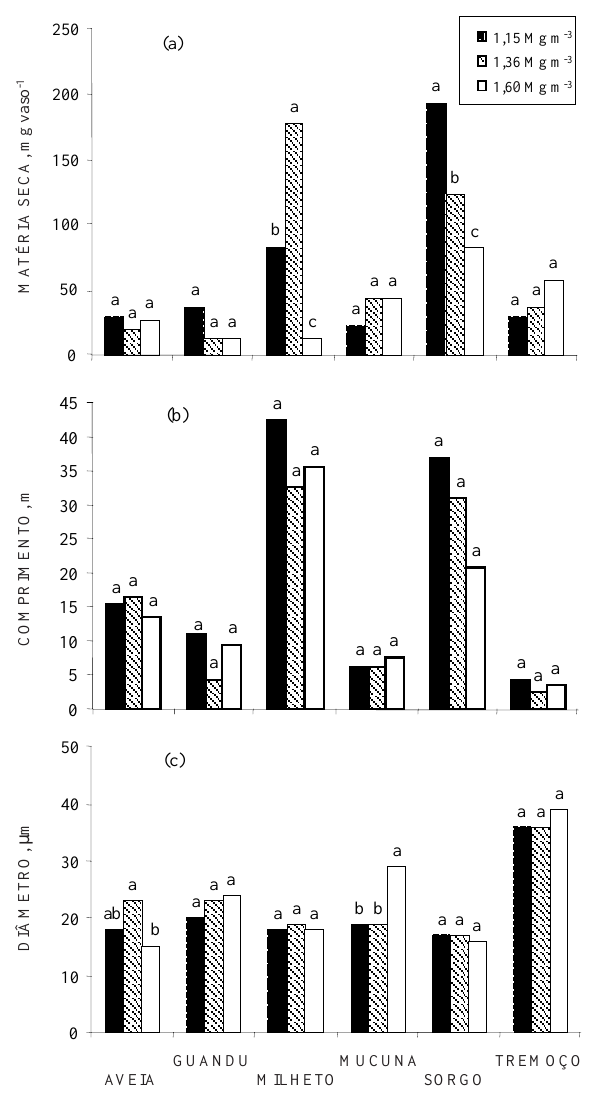
Figura 2. Produção de matéria seca (a), comprimento (b) e diâmetro (c) das raízes na profundidade de 15-18,5 cm, considerando as densidades impostas nesta